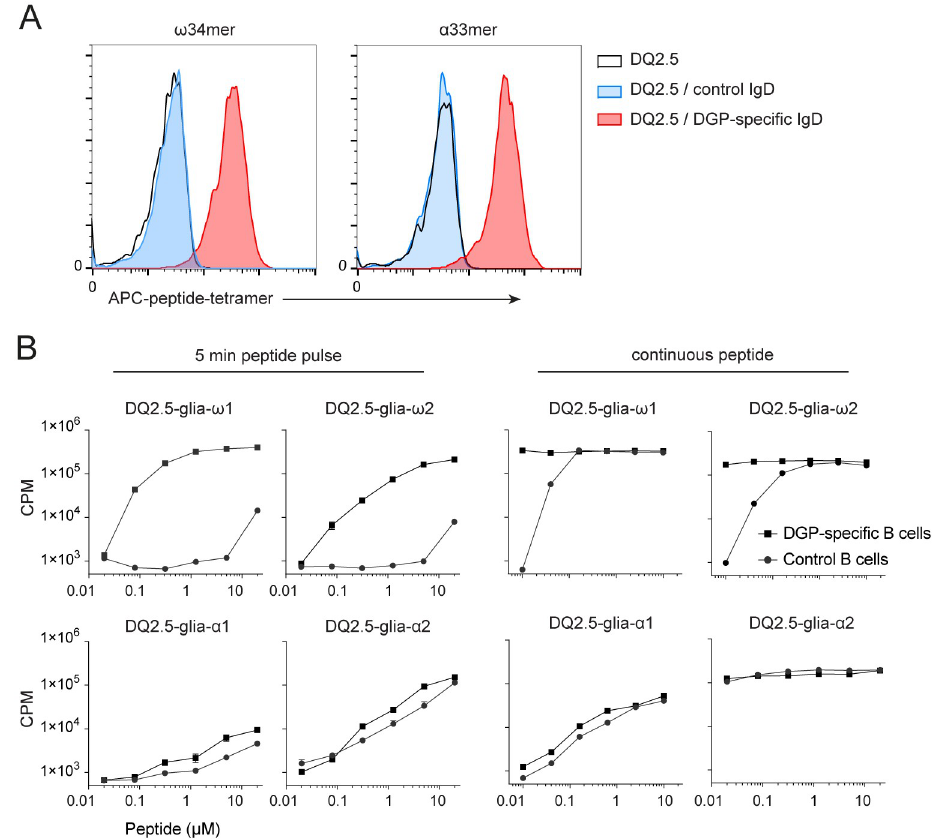
Fig 4. DGP-specific B cells efficiently bind deamidated gliadin peptides. (A) Binding of deamidated ω 34mer and α 33mer gluten peptide by A20 transfectant B cells expressing either HLA-DQ2.5 alone (black line, no fill), HLA-DQ2.5 and an irrelevant IgD BCR (693-2-F02; blue) or HLA-DQ2.5 and the gluten-specific IgD BCR 1130-3-B01 (red). Cells were stained with biotinylated deamidated ω 34mer or α 33mer that was multimerized with APC-conjugated streptavidin. (B). Presentation of deamidated gluten peptides by irradiated transfectant A20 B cells expressing HLA-DQ2.5 and the DGP-specific 3B01 IgD BCR or the 2F02 control BCR. A20 B cells were either pulsed with indicated concentrations of deamidated ω 34mer or α 33mer peptide for 5 min on ice, or peptides were present continuously during the assay. A20 B cells were cultured overnight at 37˚C before gluten-specific T cells specific for the DQ2.5-glia- ω 1 (TCC 1383.P.A.6), DQ2.5-glia- ω 2 (TCC 737.30), DQ2.5-glia- α 1 (TCC 430.1.57) and DQ2.5-glia- α 2 (TCC 436.5.3) epitopes were added. T-cell proliferation was assessed by [ 3 H] thymidine incorporation 72h later. Symbols represent mean counts per minute (CPM) +/- SEM of culture duplicates or triplicates and are representative of at least 3 independent experiments.